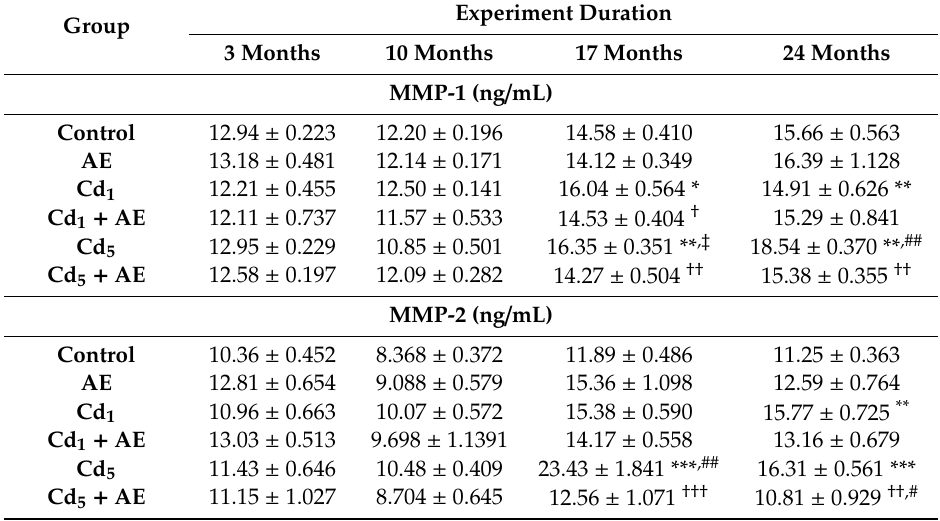
Table 4. The e ff ect of Aronia melanocarpa L. berry extract (AE) on the concentrations of matrix metalloproteinase-1 (MMP-1) and matrix metalloproteinase-2 (MMP-2) in the serum of rats treated with cadmium (Cd) 1,2 .